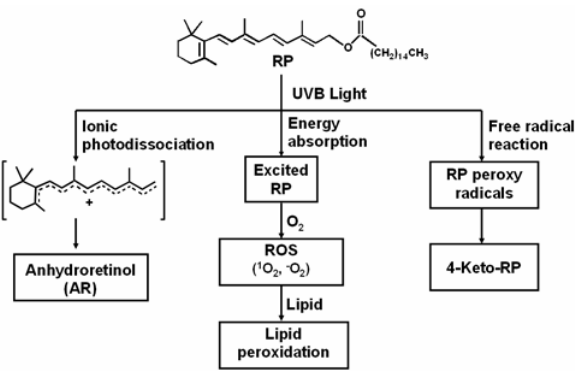
Figure 7: The proposed mechanistic pathways initiated by photoirradiation of RP with UVB light leading to generation of RP photodecomposition products, ROS, lipid peroxidation, and DNA